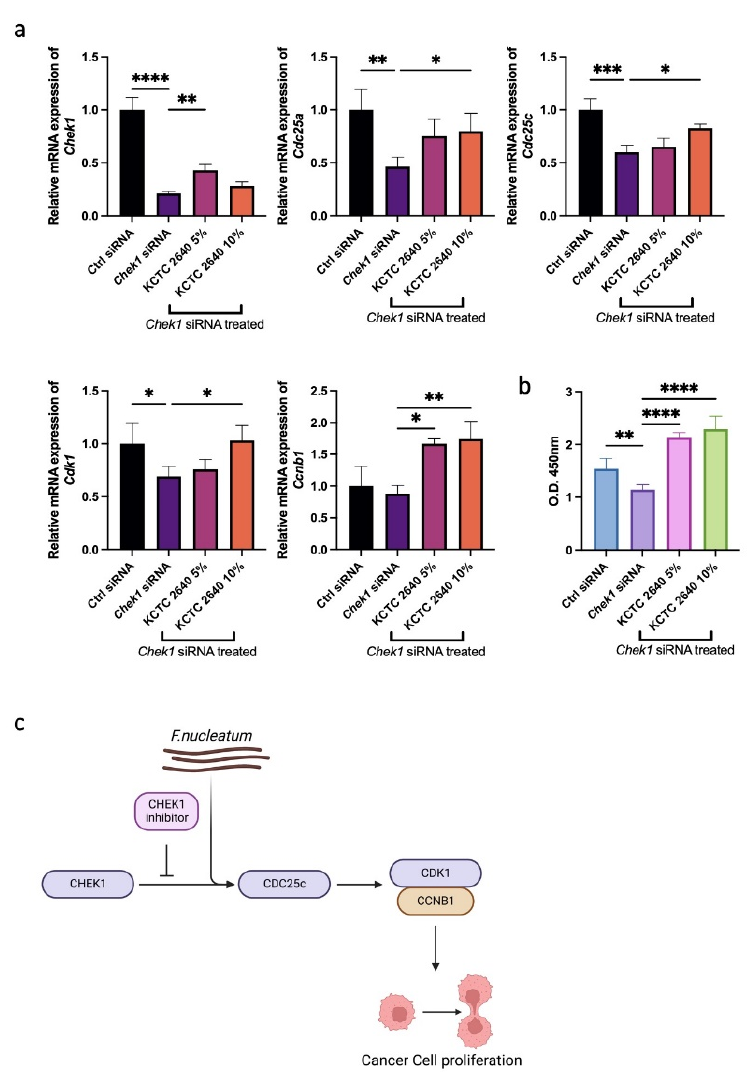
Figure 4. qRT-PCR and WST-1 assay of MC 38 cell lines. ( a ) qRT-PCR assay representing the G2M checkpoint pathway-related genes in MC 38 cell lines treated with Chek1 siRNA and F. nucleatum . ( b ) WST-1 assay demonstrating the cell proliferation of MC 38 cell lines treated with Chek1 siRNA and F. nucleatum . ( c ) Scheme of the G2M checkpoint pathway and effect of F. nucleatum . * p < 0.05, ** p < 0.01, *** p < 0.001, **** p < 0.0001. Statistical significance was calculated using Bonferroni tests.